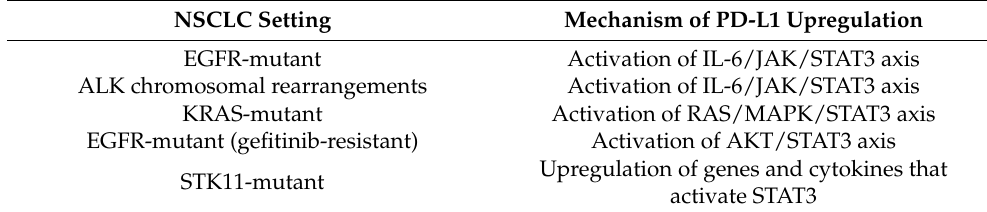
Table 2. STAT3-related mechanisms of PD-L1 regulation in